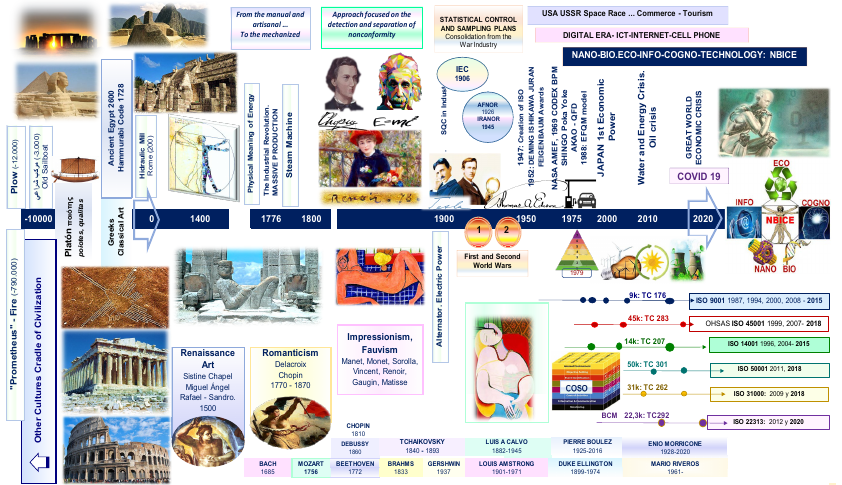
Figure A7. Timeline in the development of QHSE3+ standards in correlation with the milestones of humanity [13,100].